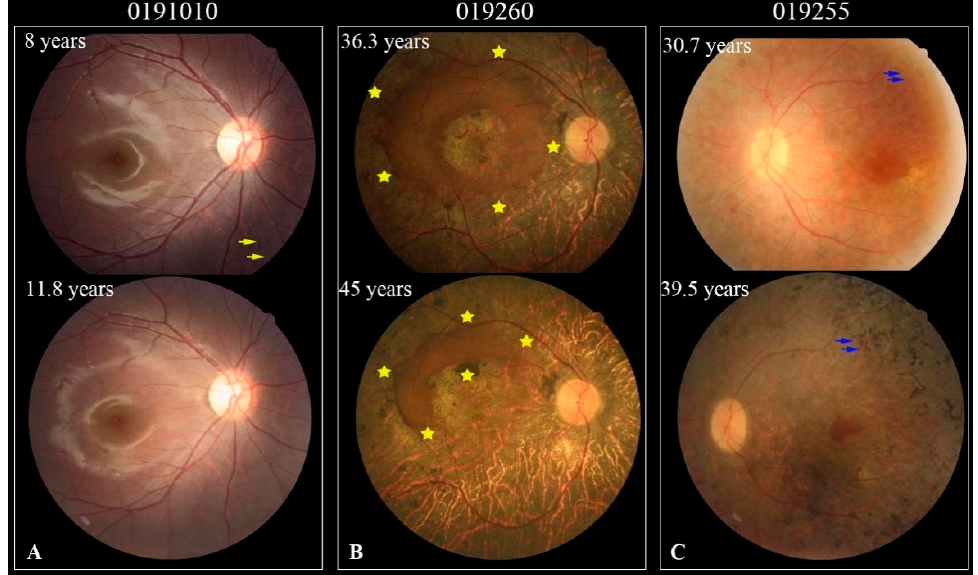
Figure 6. Colored fundus (CF) photographs of three patients during their follow-up. ( A ) CF photographs of patient 0191010 show that some white dots (yellow arrow) disappeared about three years later. ( B ) CF images of patient 019260 display an atrophy enlargement in the posterior pole during nearly nine years of follow-up. The relatively normal retina is surrounded by yellow asterisks. ( C ) CF photographs of patient 019255 show an increase in bone spicules (blue arrow) with aging.